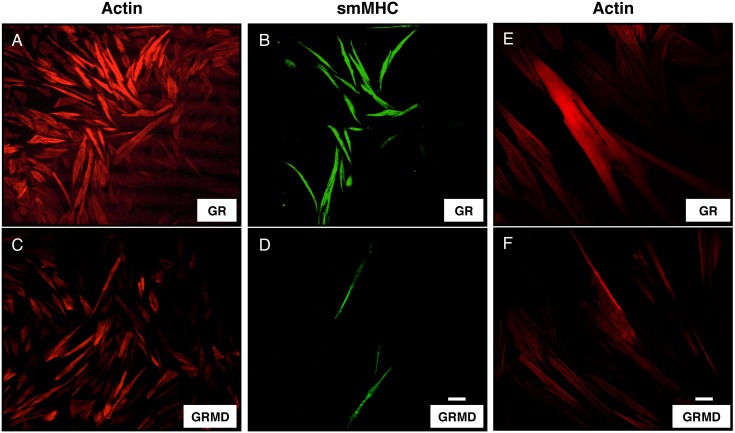
Effect of dystrophin on stress fibers and contractile marker myosin heavy chain.Primary cultured tracheal smooth muscle cells from (GR & GRMD) animals were grown to confluence on glass coverslips and subjected to 7 day culture in serum deficient conditions. Thereafter myocytes were fixed, and double labeled for (A, C) phalloidin, which stains f-actin, and (B, D) smMHC. Isotype-matched mouse IgG or rabbit antiserum was used for negative controls (not shown). Antibodies conjugated with TxR or FITC were used to label actin filaments (red) and smMHC (green) respectively. Images were obtained by confocal laser scanning microscope. Higher magnification of Fig. A & C for stress fibers are shown in panel E and F showing fluorescent phalloidin (red) marking actin filaments in GR (E) and GRMD (F). Images are representative of at least 6–9 in vitro experiments obtained from 3 different GR (normal) and GRMD (dystrophic) animals respectively. Scale bars, 100 µm (A–D) and 20 µm (E–F).